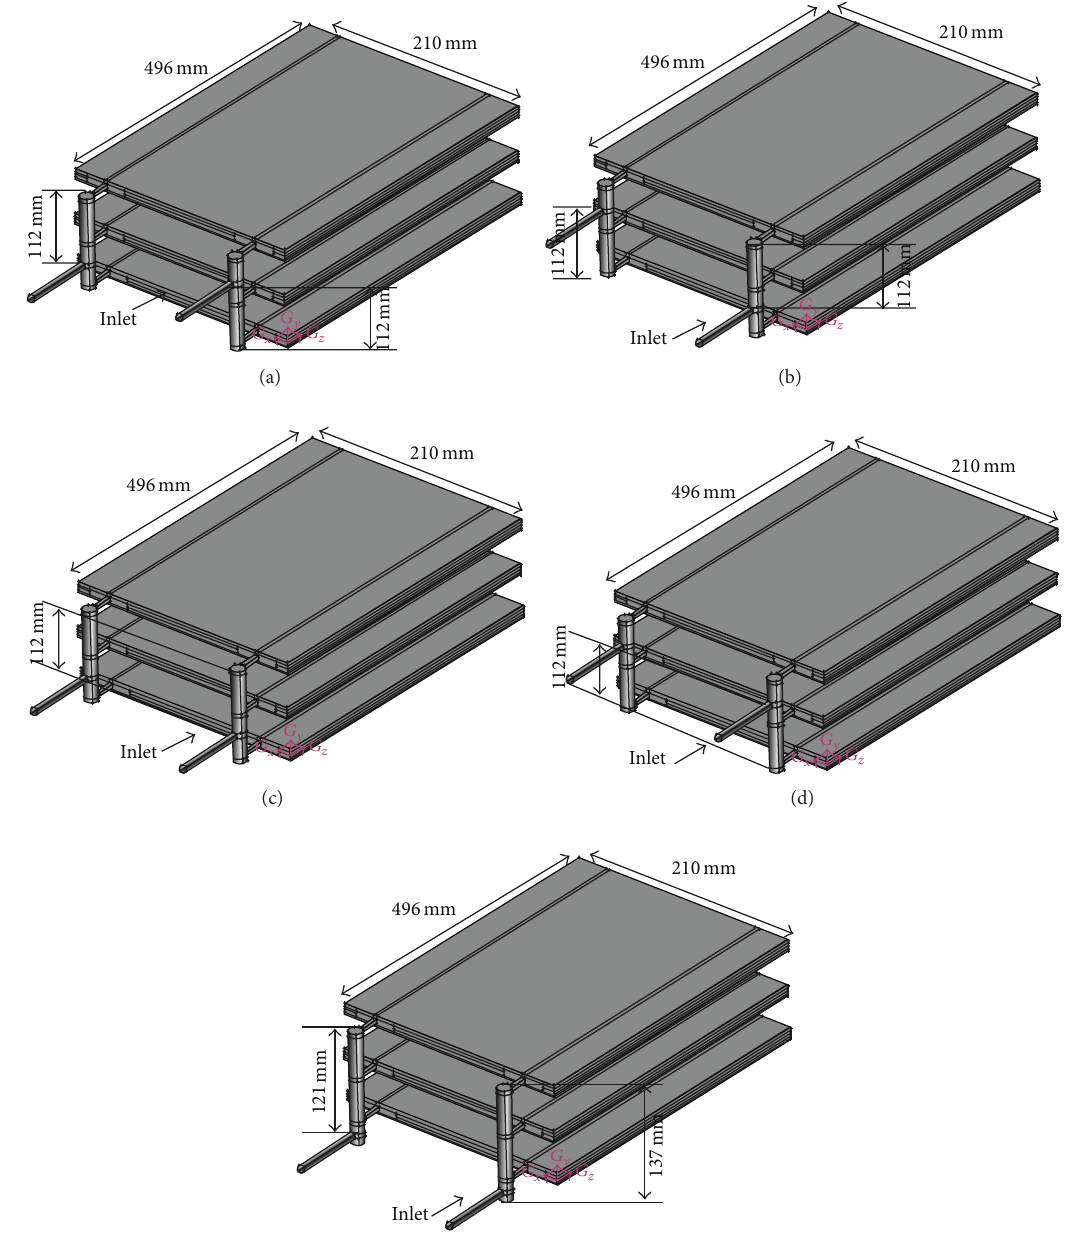
Figure 2: Geometric shapes of (a) Case 1, (b) Case 2, (c) Case 3, (d) Case 4, and (e) Case